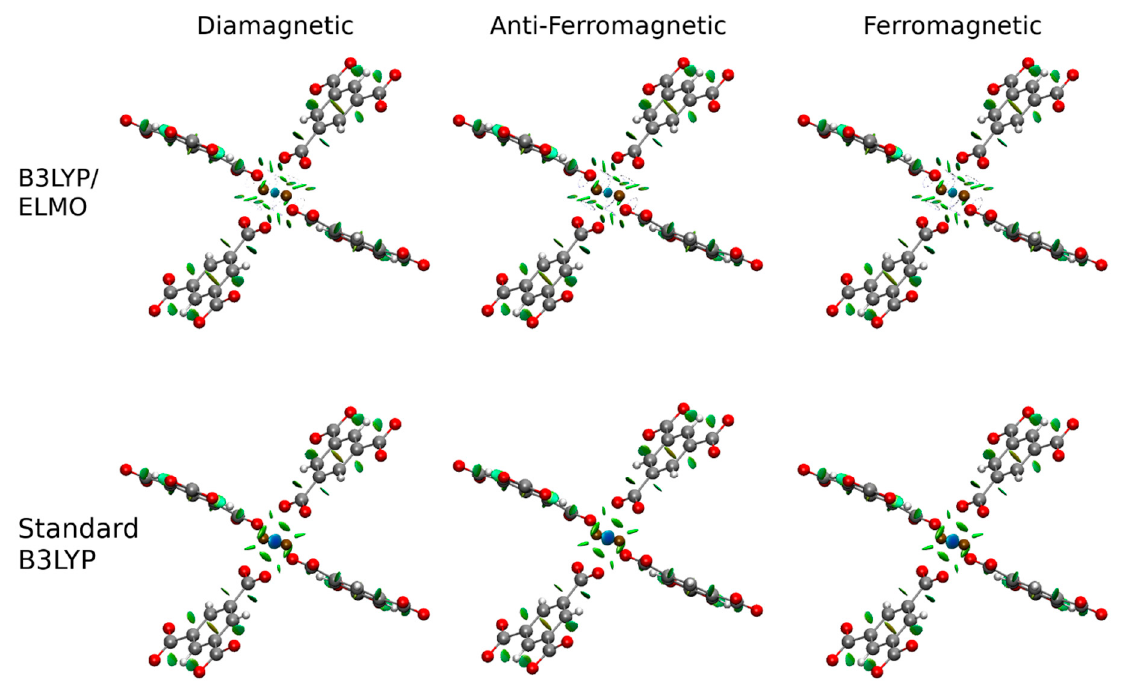
Figure 3. NCI plots at different levels of theory with basis set 6-311G(2d,2p) for the model system extracted from the HKUST-1 experimental crystal structure with water chemisorption degree of 14.3(6)%. All the reduced-density gradient isosurfaces correspond to the 0.4 a.u. isovalue and are colored according to the BGR (blue-green-red) scheme over the range − 5.0 a.u < sign ( λ ) ρ < 5.0 a.u.